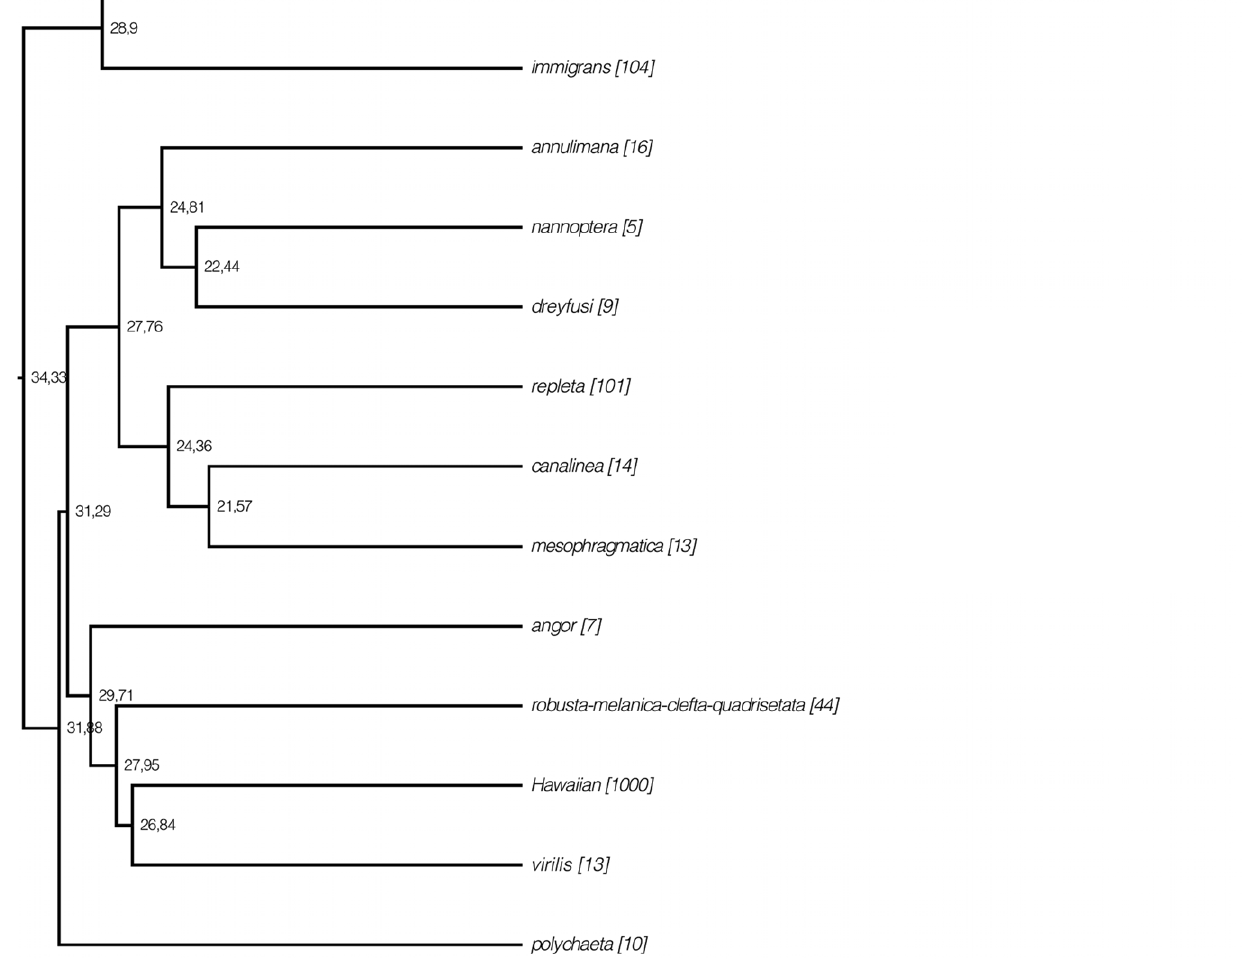
Figure 5. Backbone topologies used in the MEDUSA analyses. A) phylogeny backbone from analysis with 218 species and 9 calibration points; B) phylogeny backbone from analysis with 218 species and 5 calibration points. Tip names refer to the species groups (those polyphyletic were clustered into a single clade) and numbers in brackets refer to the species richness of the tip. Numbers on nodes indicate divergence times.